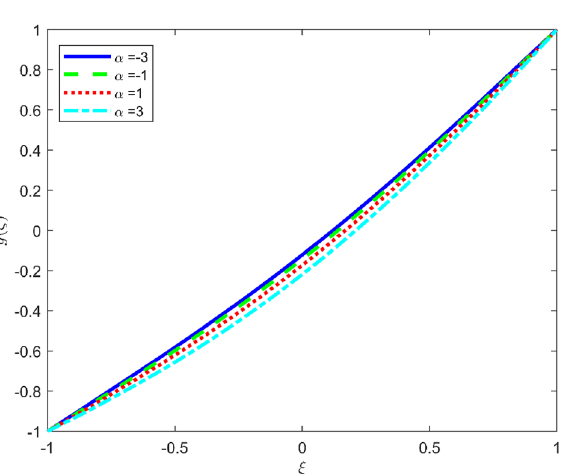
Figure 4. Effect of α upon velocity profile g (ξ) , for selected values of β = 0.2, m = 1, Ha = 1, φ 1 = φ 2 =